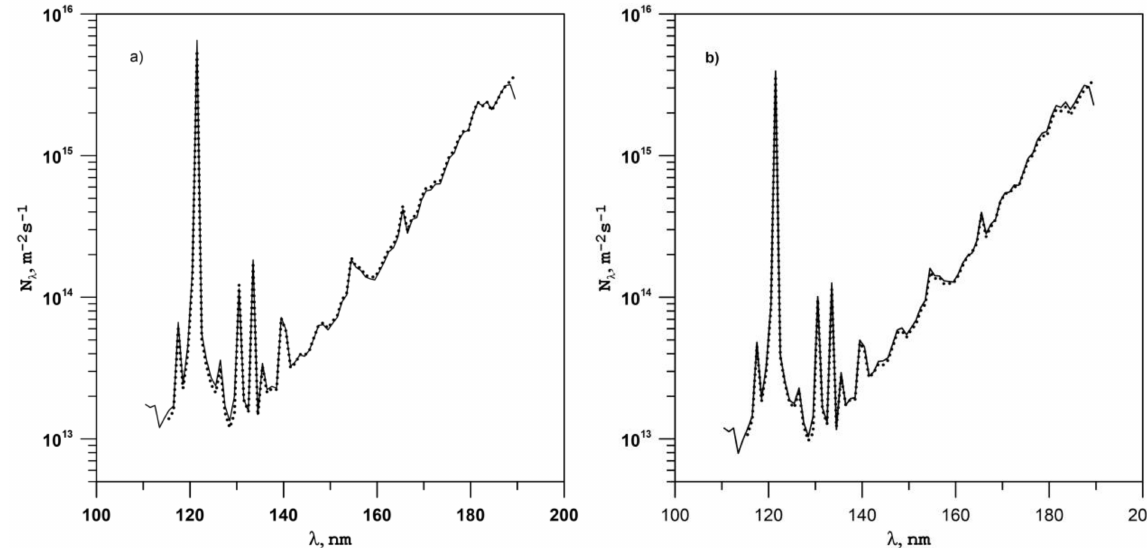
Figure 5. Comparison of model calculations with TIMED/SEE data. ( a ) Near the maximum of activity, 21 February 2002, ( b ) Near the minimum of activity, 21 February 2009. Solid line—measurement data, dashed line—model